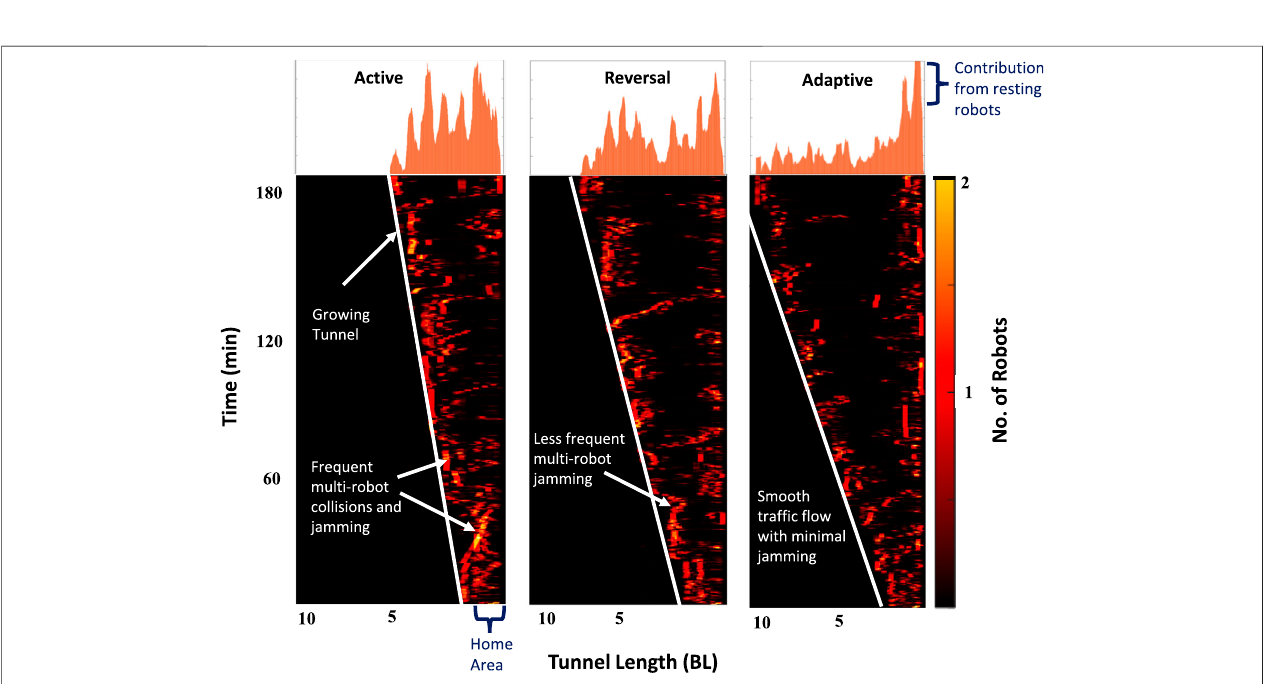
FIGURE7| Experimentalspace-timeoverlapheatmapsofrobotpositionsalongthetunnel(x-axis)measuredinbody-lengths(BL).Y-axisisthetimedurationofthe experiment in minutes. White straightlinesshow how fast thetunnel grows which depends on the running protocol in the robots. Robotsstart from the Home area (right side) and transit to the Digging area (left side) continuously while excavating the pellets.